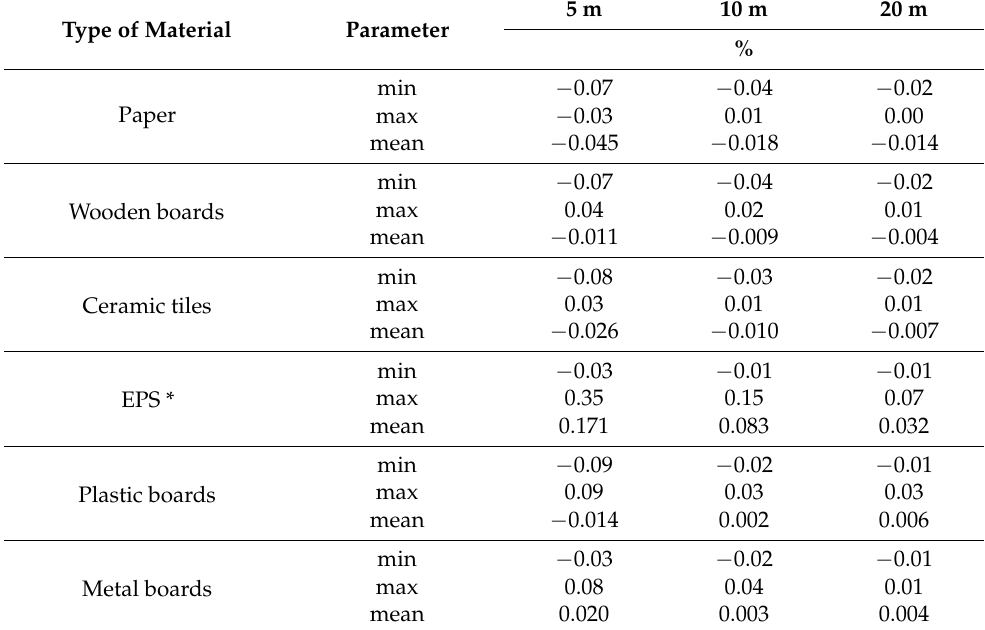
Table 3. Mean values of relative RL EDM errors at distances: 5, 10 and 20